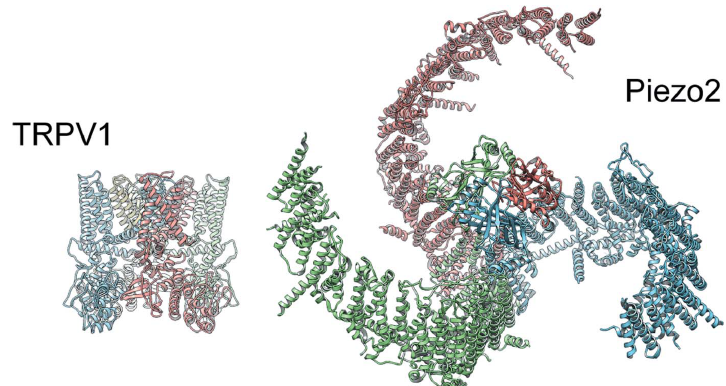
Figure 1 Structures of TRPV1 (left) and Piezo2 (right) represented in ribbon diagram. Piezo2 is slightly tilted around the horizontal axis to reveal its three-bladed propeller shape. Both structures were determined by single-particle